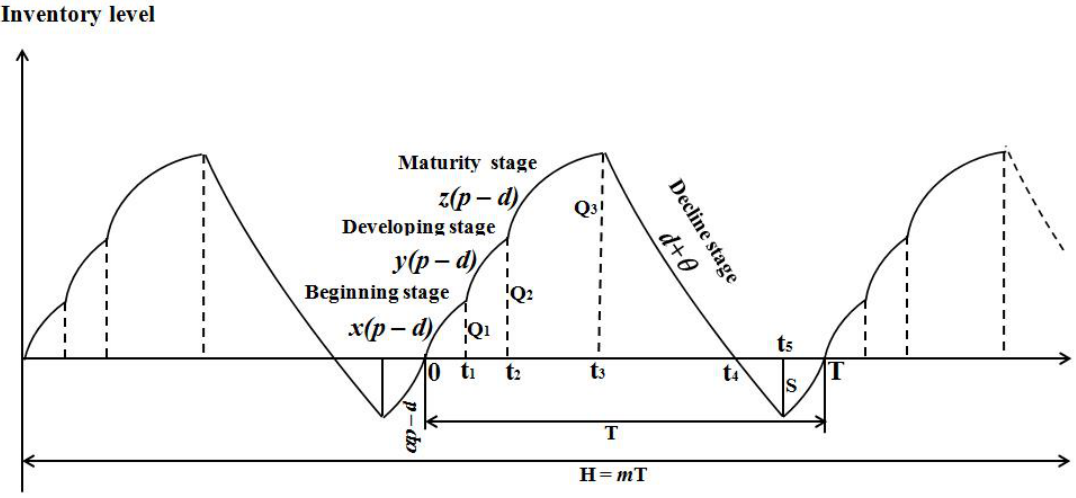
Fig 1: Inventory level of finished goods for i th replenishment